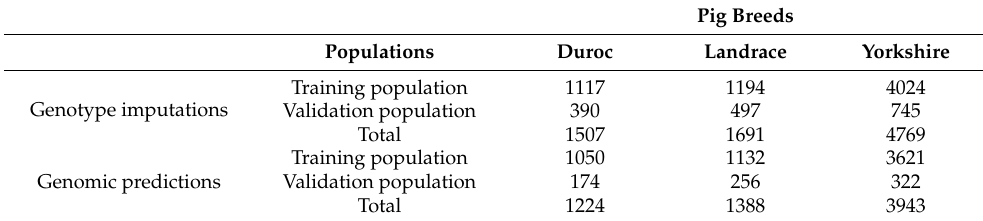
Table 1. Number of animals in the training and validation populations.